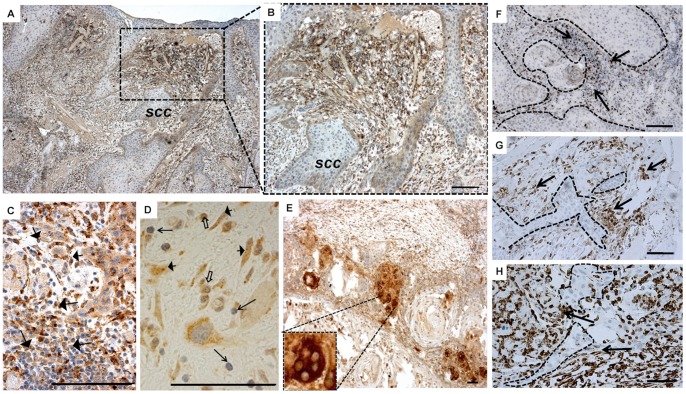
Cathepsin K is expressed by various stromal cells.Adjacent stroma of some OTSCC tumors shows strong staining for cathepsin K (A–B). Arrows show several round nuclear inflammatory and spindle mesenchymal cells in OTSCC stroma that have abundant cathepsin K staining (C–D). In matching areas of the TME, where cathepsin K was expressed, we also observed cells positive for the selective immunohistochemical markers CD45 (F), CD68 (G), and vimentin (H), confirming the presence of inflammatory and mesenchymal cells. Arrows indicate positive cells and dotted lines indicate OTSCC cell islands (F–H). Multinucleated giant tumor cells are intensively stained for cathepsin K (E). Scale bars 200 µm.